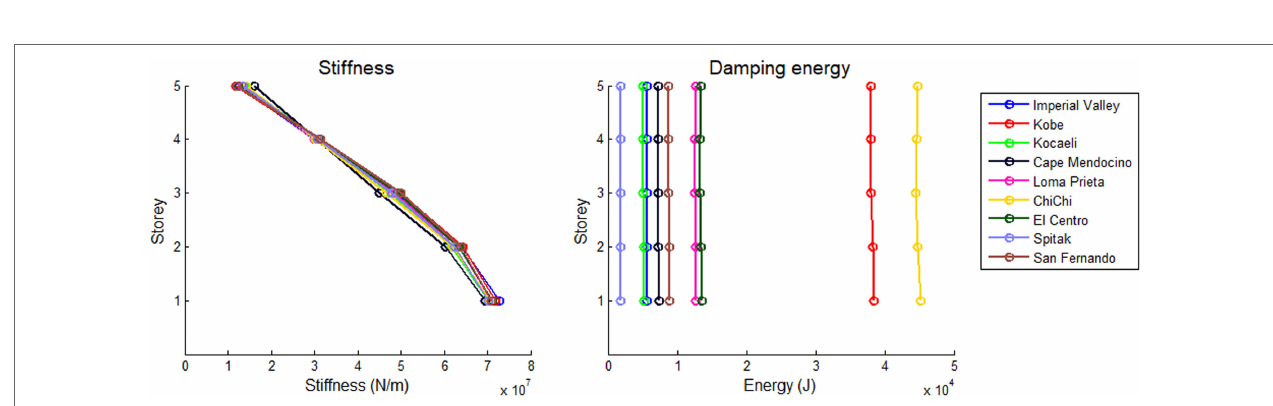
is much lower, and sometimes becomes 0 (i.e., the upper floors